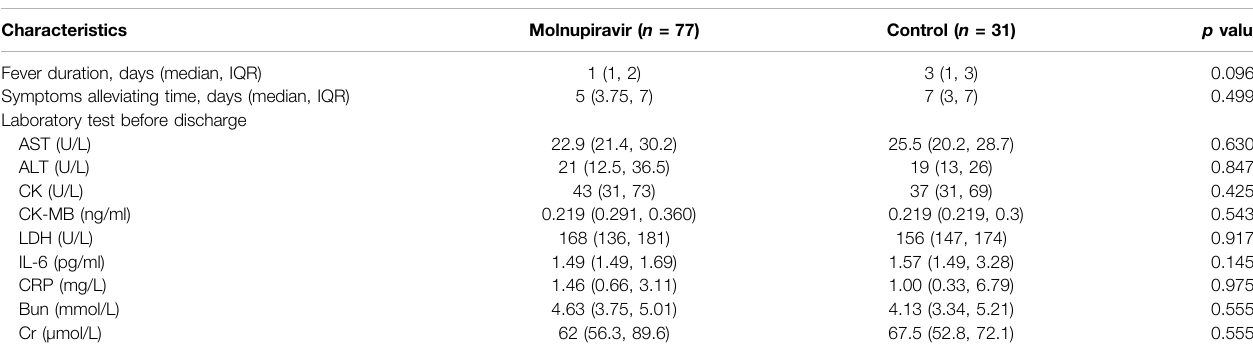
TABLE 4 | Clinical outcomes associated with COVID-19.